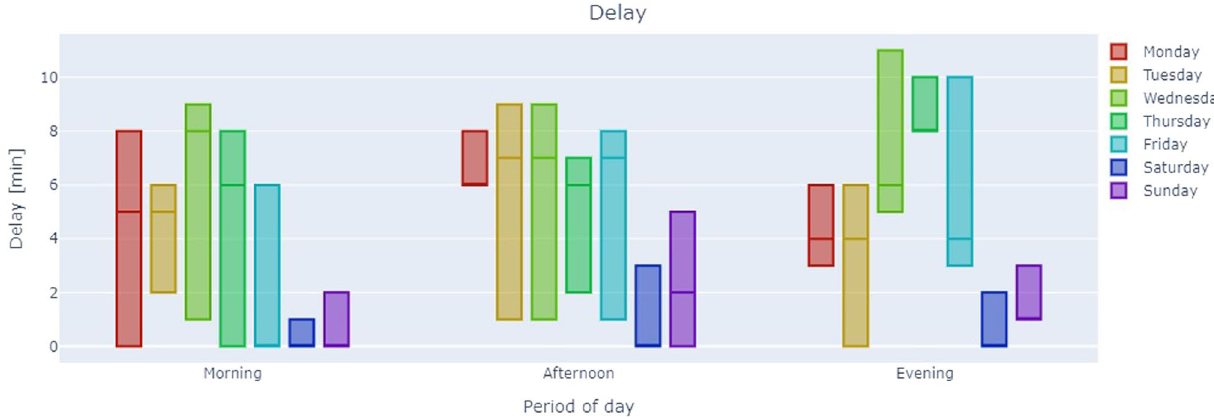
Fig. 9 Delay measurements